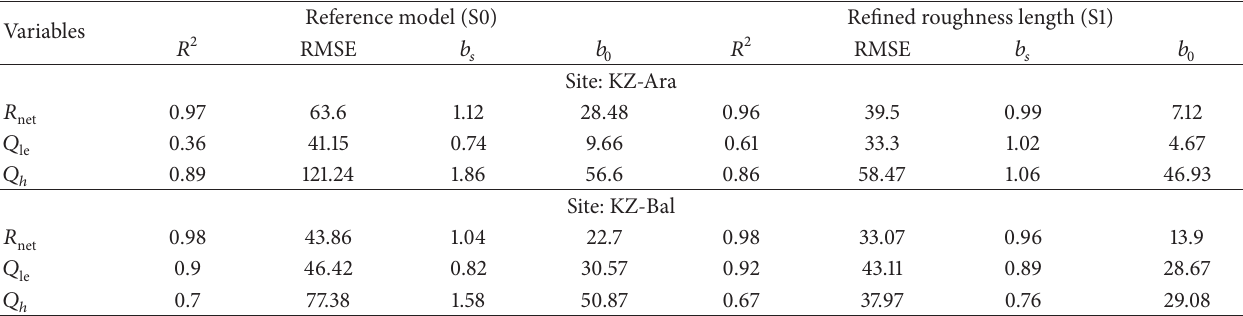
Table 4: Model performance for simulating 𝑅 root mean square error (RMSE, Wm −2 ) of linear regressions between model and observed data at the KZ-Ara site and the KZ-Bal